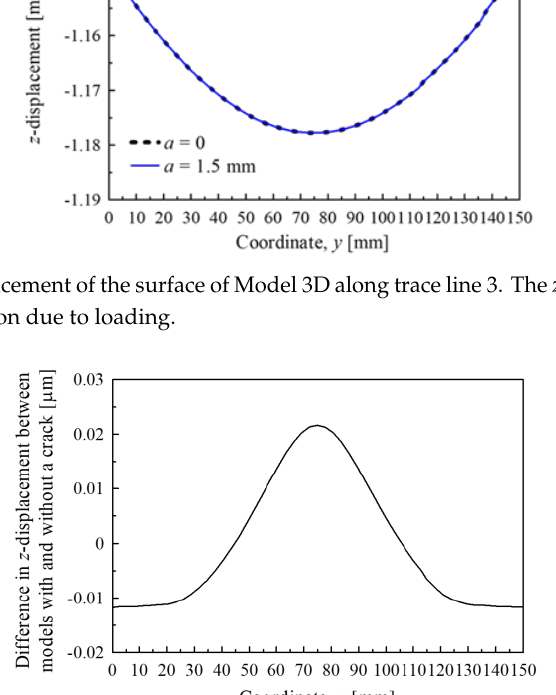
Figure 17. The difference in the z -displacement between the models with and without a crack of Model 3D along trace line 2.